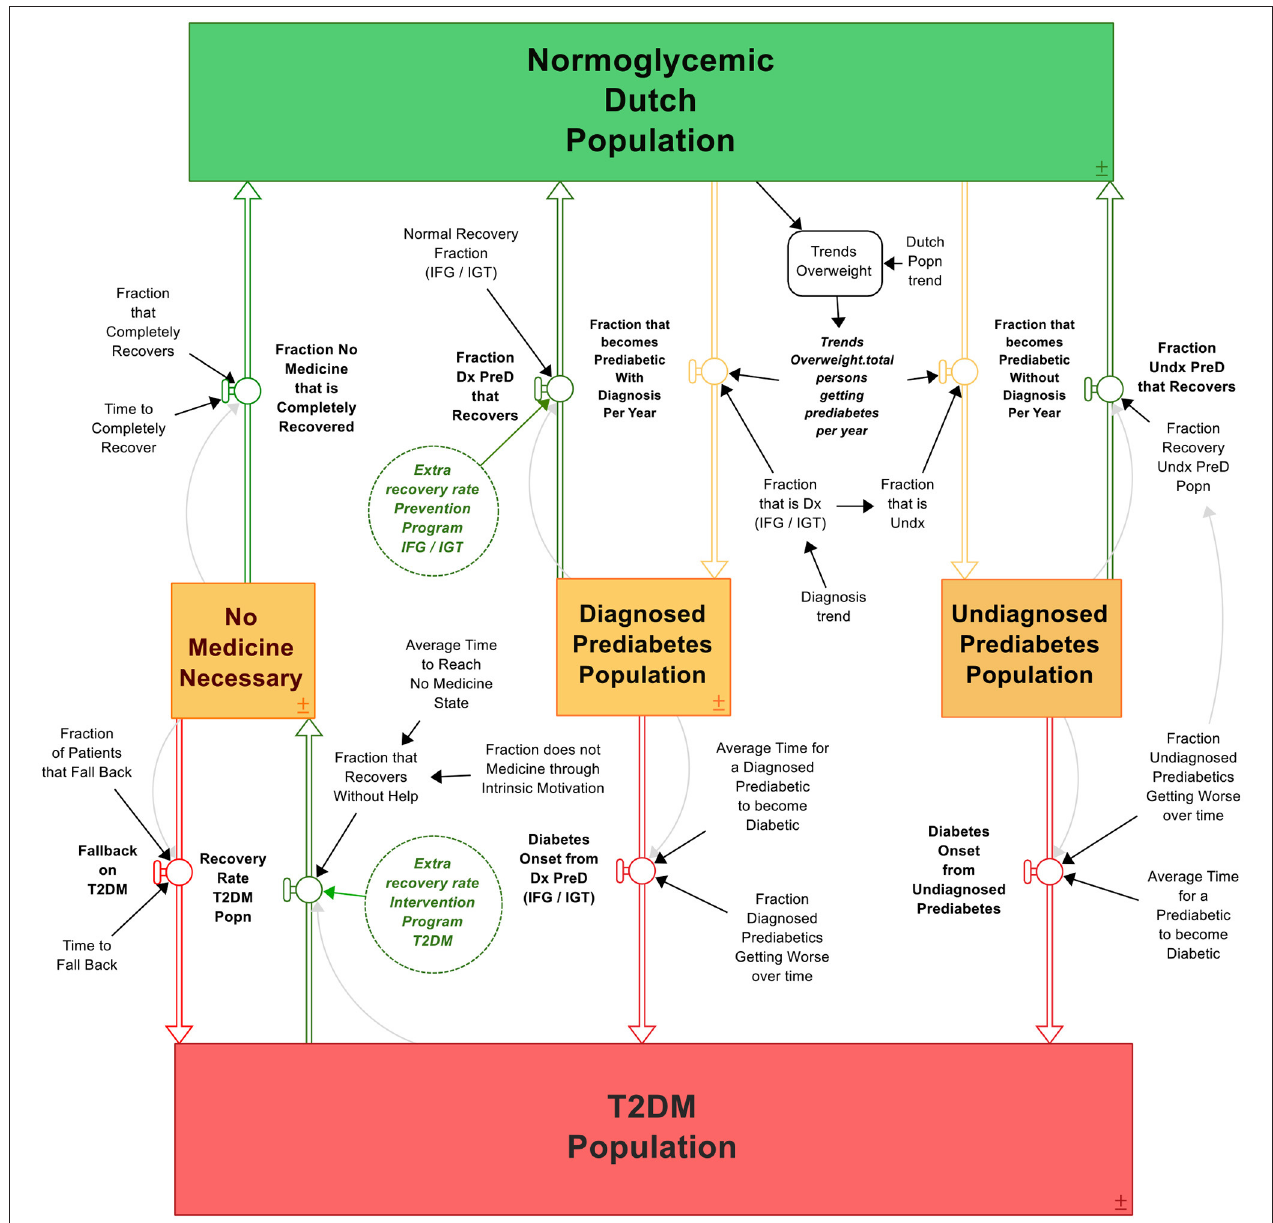
FIGURE 3 | The T2DM patient journey. Boxes are stocks that accumulate over time, double arrows are in- or outflows that either give input or take output of the stock. Circles are variables that affect the in- or outflows, containing parameter values. Clouds are outputs that “flow out of the system” like deaths. The process is visualized from green (healthy) to orange (likely to develop T2DM) to red (developed T2DM), with multiple possibilities to bounce back in the system to “healthy” (green arrows). The system contains the differential equations as described in section The Construction of the T2DM Patient Journey